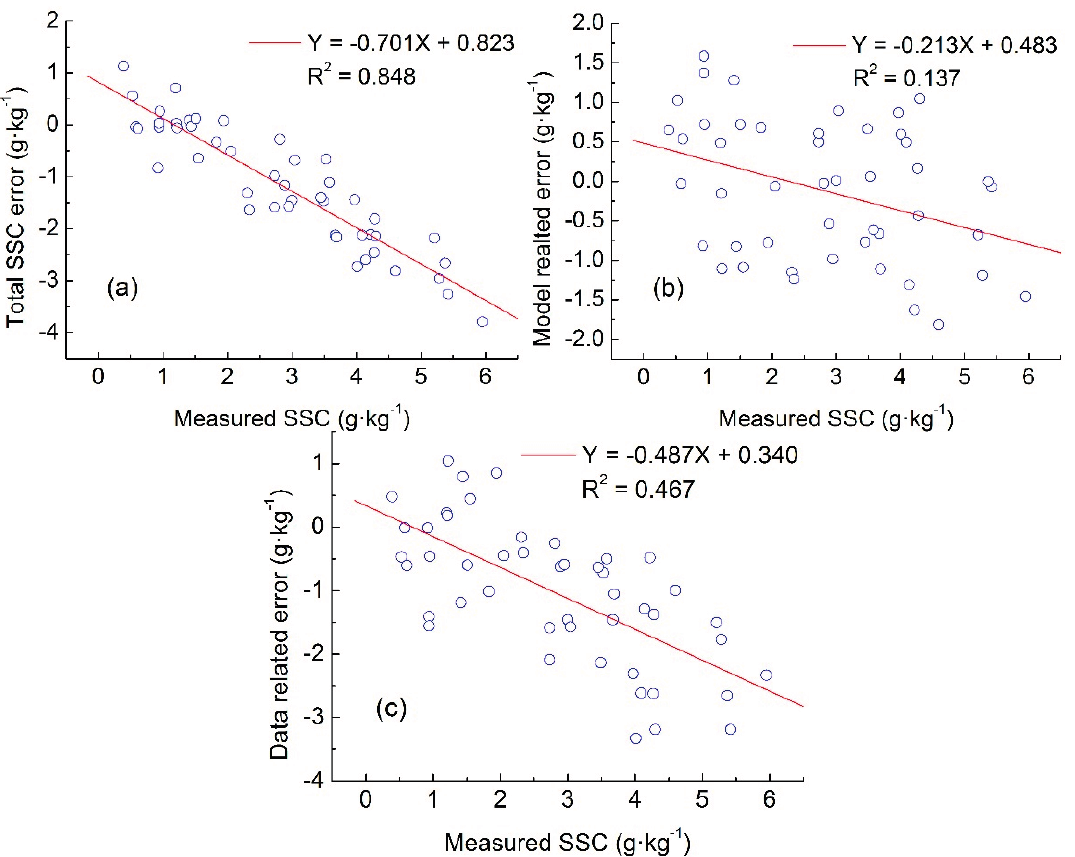
Figure 8. Scatterplots of measured soil salinity versus total retrieval error ( a ); model related error ( b ) and data related error ( c ). Slope and intercept values for linear regression and R 2 value are given for each